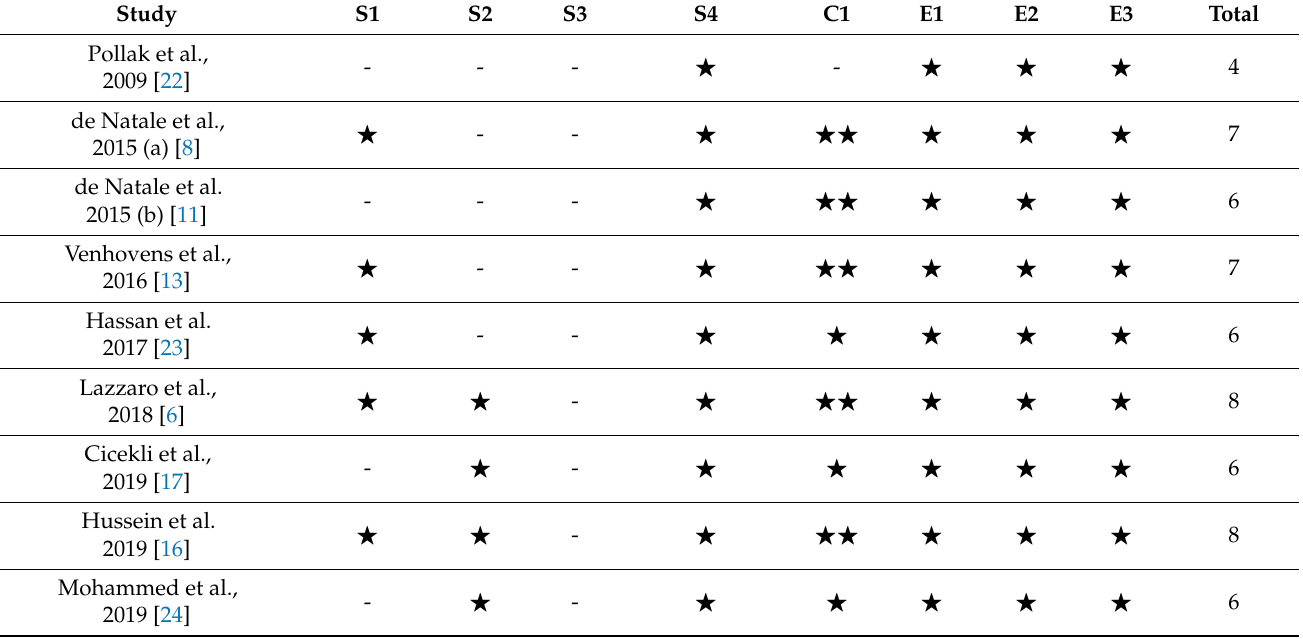
Table A2. Quality Assessment of Included Studies Using the Newcastle–Ottawa Scale